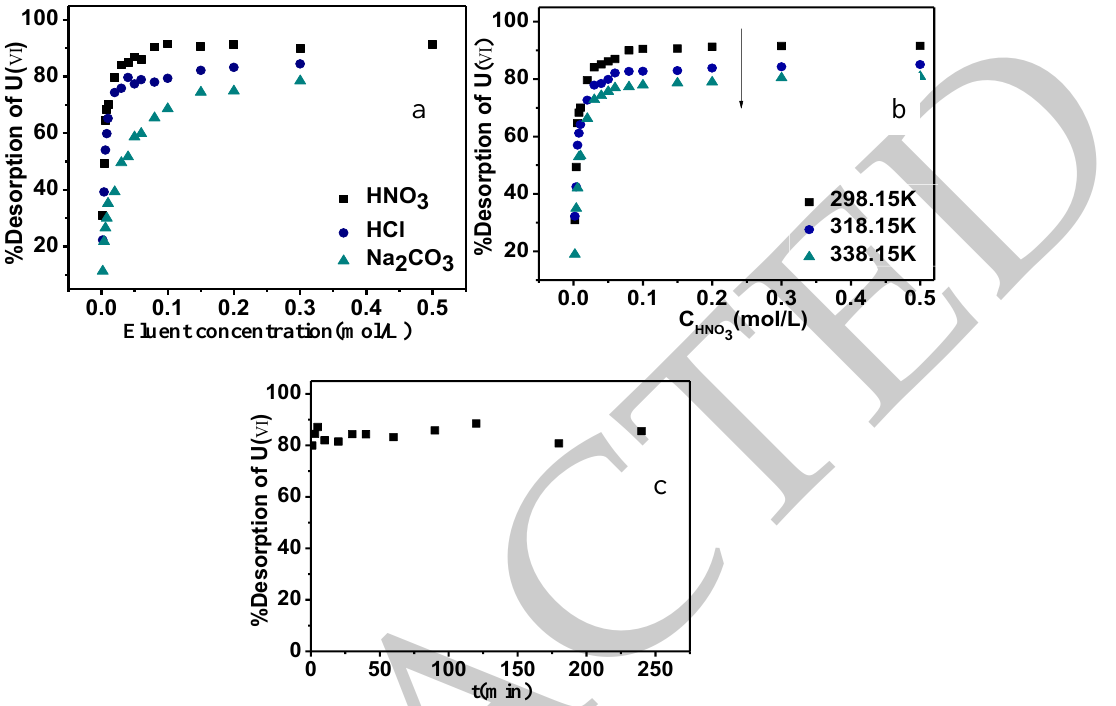
Figure 14. E ff ect of the eluent concentration ( a ), temperature ( b ) and contact time ( c ) g on the desorption of U(VI) onto β -CD- g -(MAH- co -AO). (Conditions: [U(VI)] 0 = 4.124 × 10 − 4 M, pH = 4.00 ± 0.05, I = 0.50 M NaNO 3 , t = 4 h, m / V = 0.40 g / L).